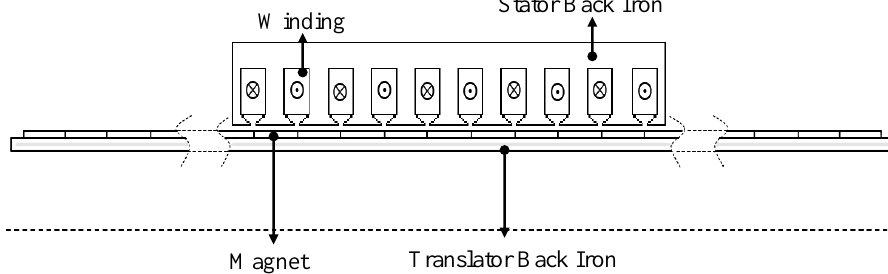
Figure 3. 2-Dimension Quarter Symmetry Cross-Section of TPMLM-NS Design Variant.